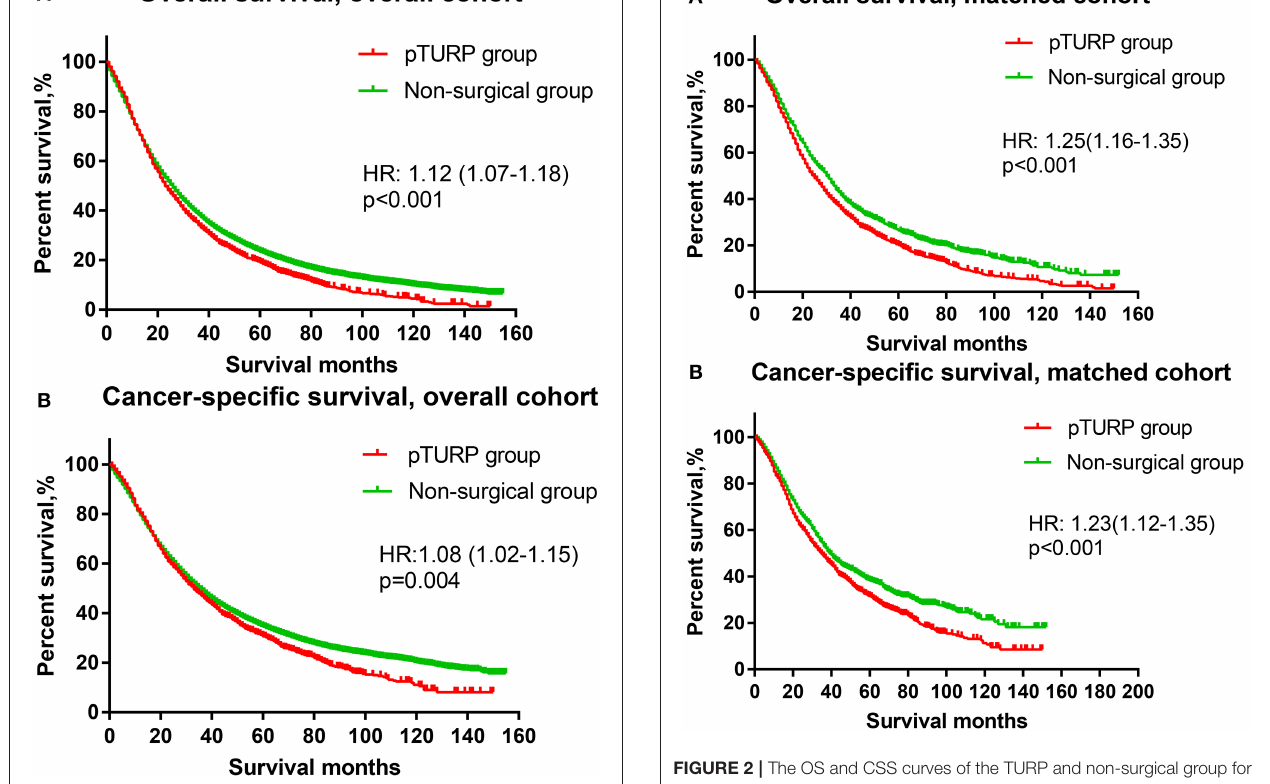
FIGURE 2 | The OS and CSS curves of the TURP and non-surgical group for patients with mPCa in the matched cohort. (A) OS curve (B) CSS